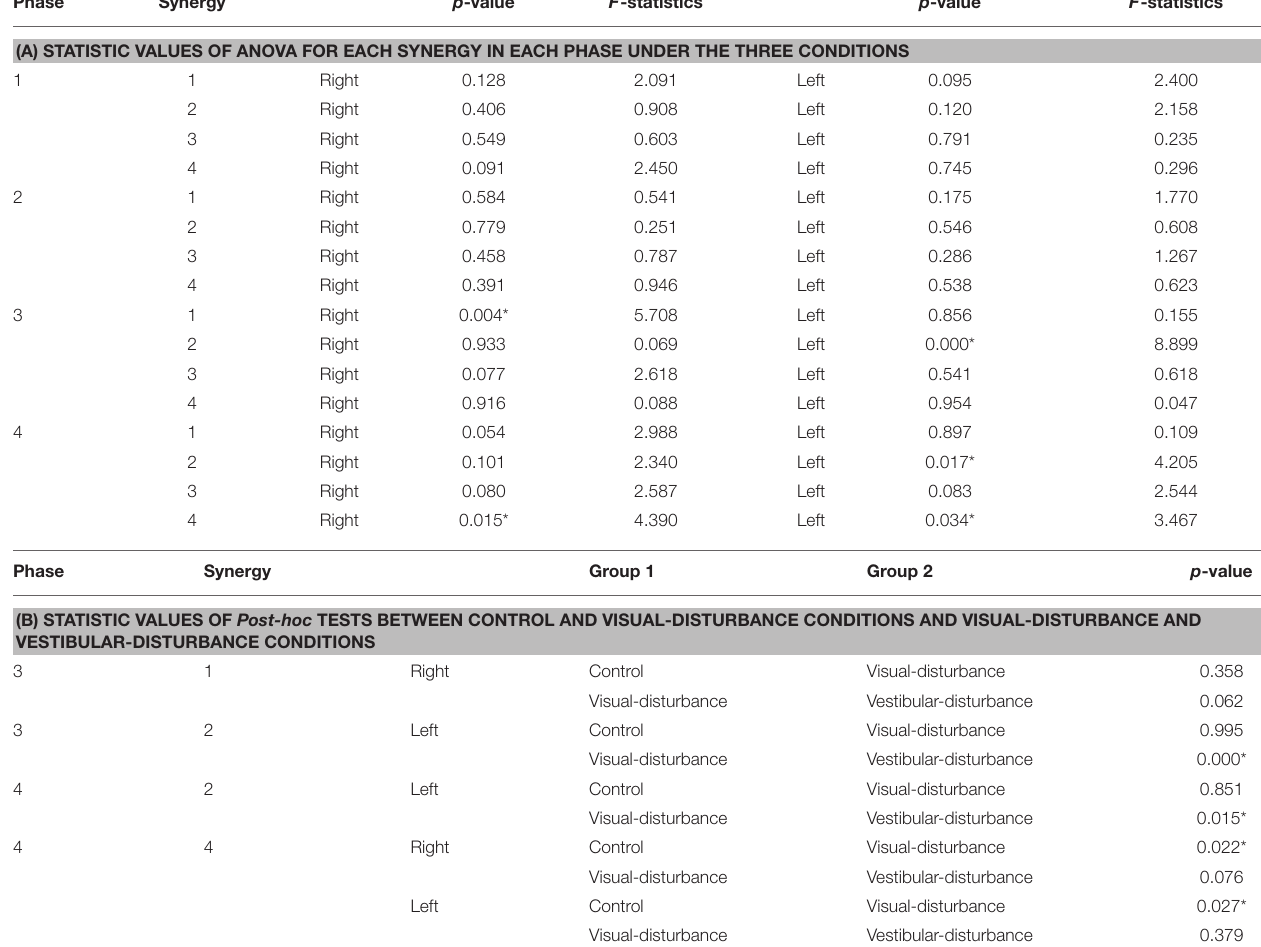
TABLE 2 | Amplitudes of temporal patterns compared for each phase under the three conditions.